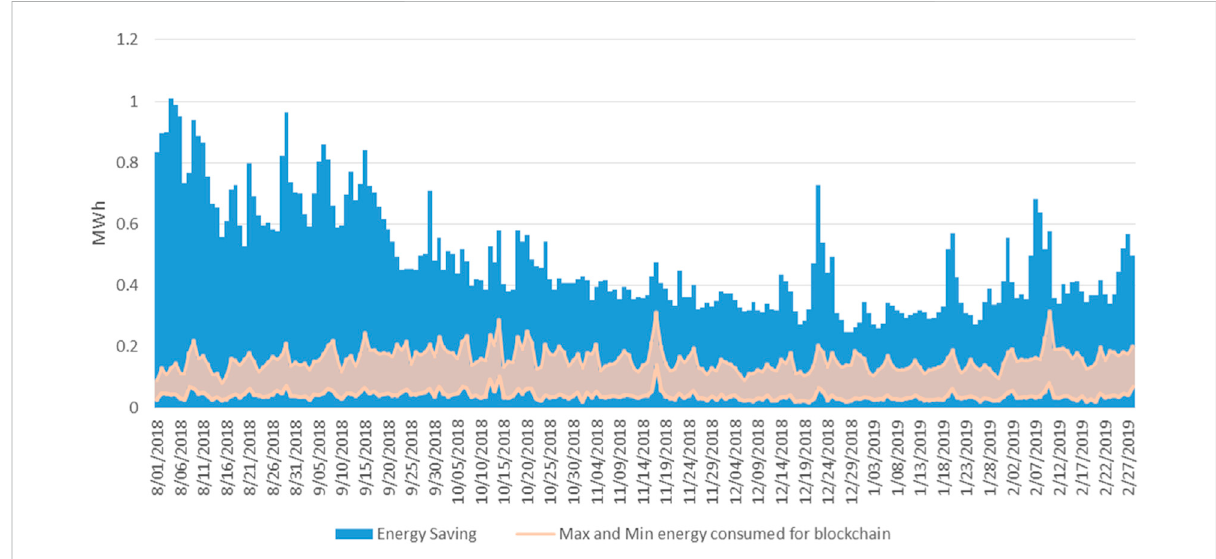
FIGURE 3 Power expended to mine blockchain compared with households ’ energy import (energy